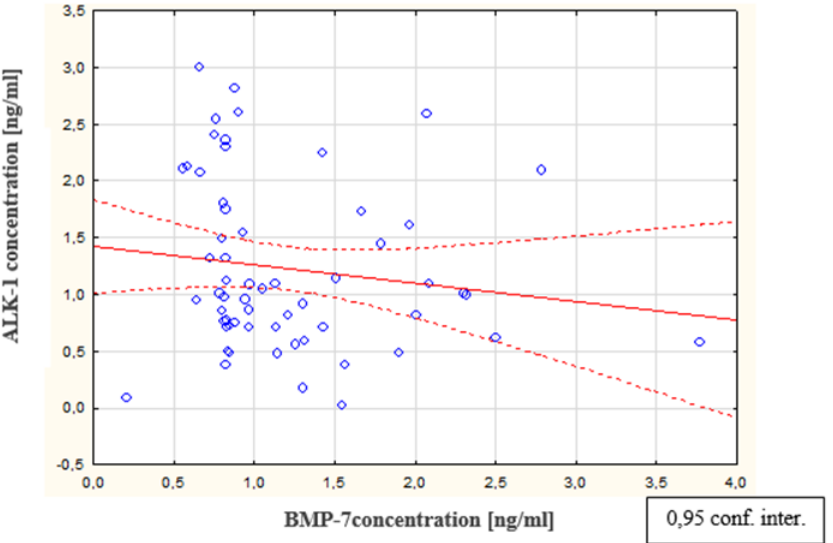
Figure 7. Linear regression curve illustrating the correlation between concentrations of ALK-1 and BMP-7 in the peritoneal fluid of women with endometriosis.